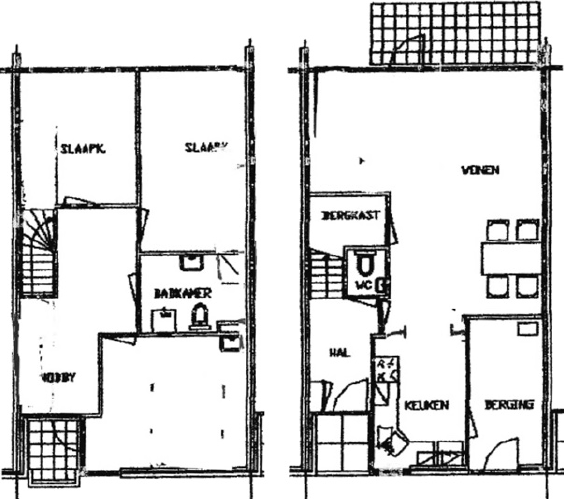
Figure 17. Kempenaar’s house plans. Source: Flevolands archive.